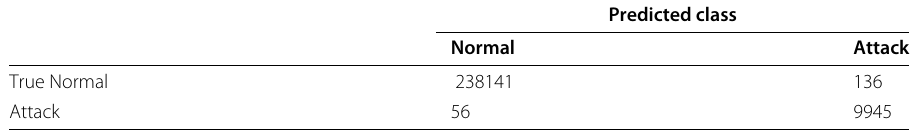
Table 12 Results of the semi-supervised anomaly detection approach: confusion matrix resulting when applying the model to test data Predicted class Normal Attack True Normal 238141 136 Attack 56